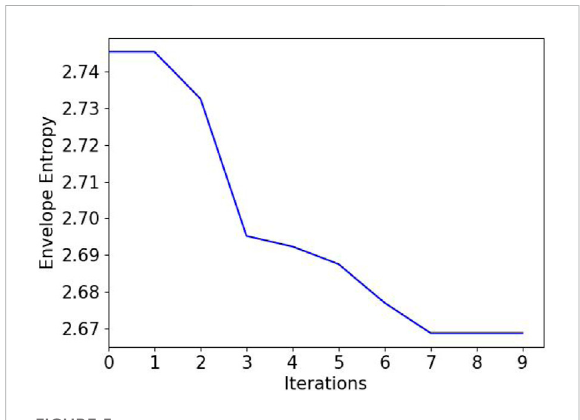
FIGURE 5 Envelope entropy changes with the evolutionary